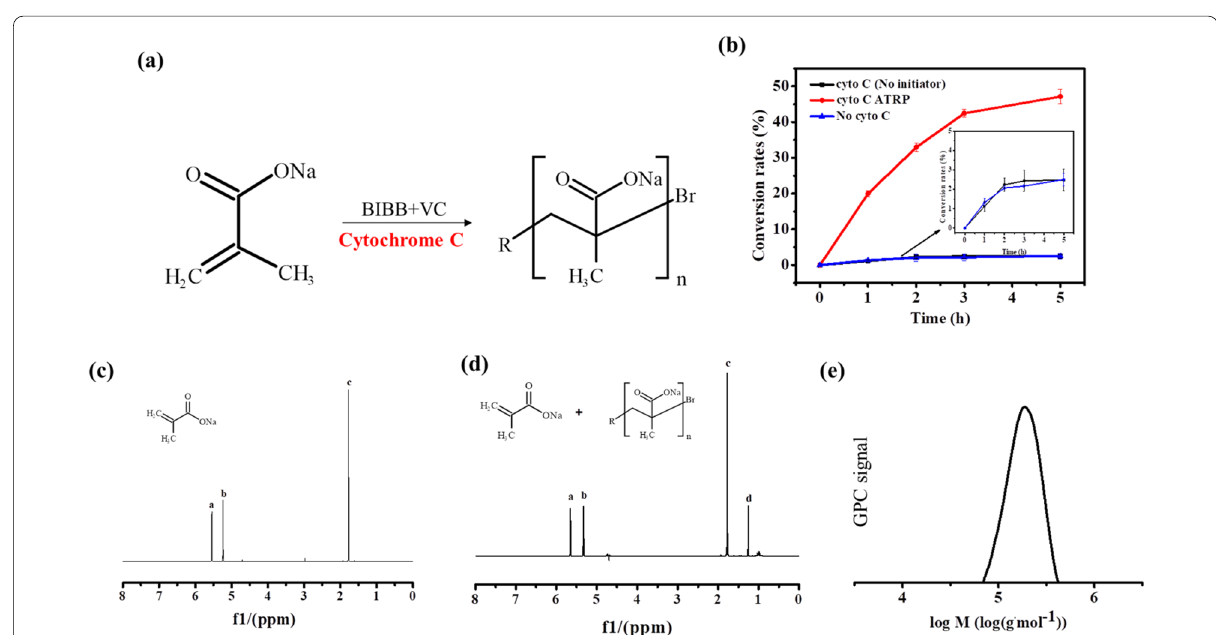
Fig. 1 a Schematic of cytochrome C catalyzed ATRP polymerization of SMA to PSMA. b Conversion of SMA by cytochrome C catalyzed ATRP under anaerobic condition. Inset is the enlarged view of the selected lines. c 1 H NMR spectrum of SMA monomer. d 1 H NMR spectrum of PSMA/SMA mixture synthesized by cytochrome C catalyzed ATRP under anaerobic condition. e GPC curve of the PSMA synthesized by cytochrome C catalyzed ATRP under anaerobic